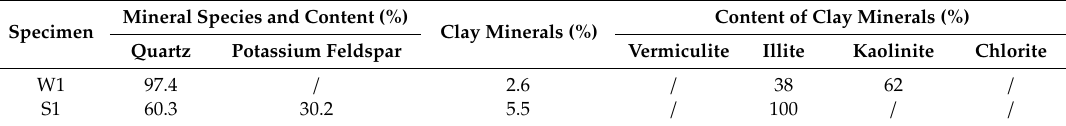
Figure 1. Specimens investigated in the imbibition experiments. W1 is a fine sandstone, and S1 is a silty sandstone. Table 1. Mineral compositions of the fine sandstone (W1) and silty sandstone (S1).